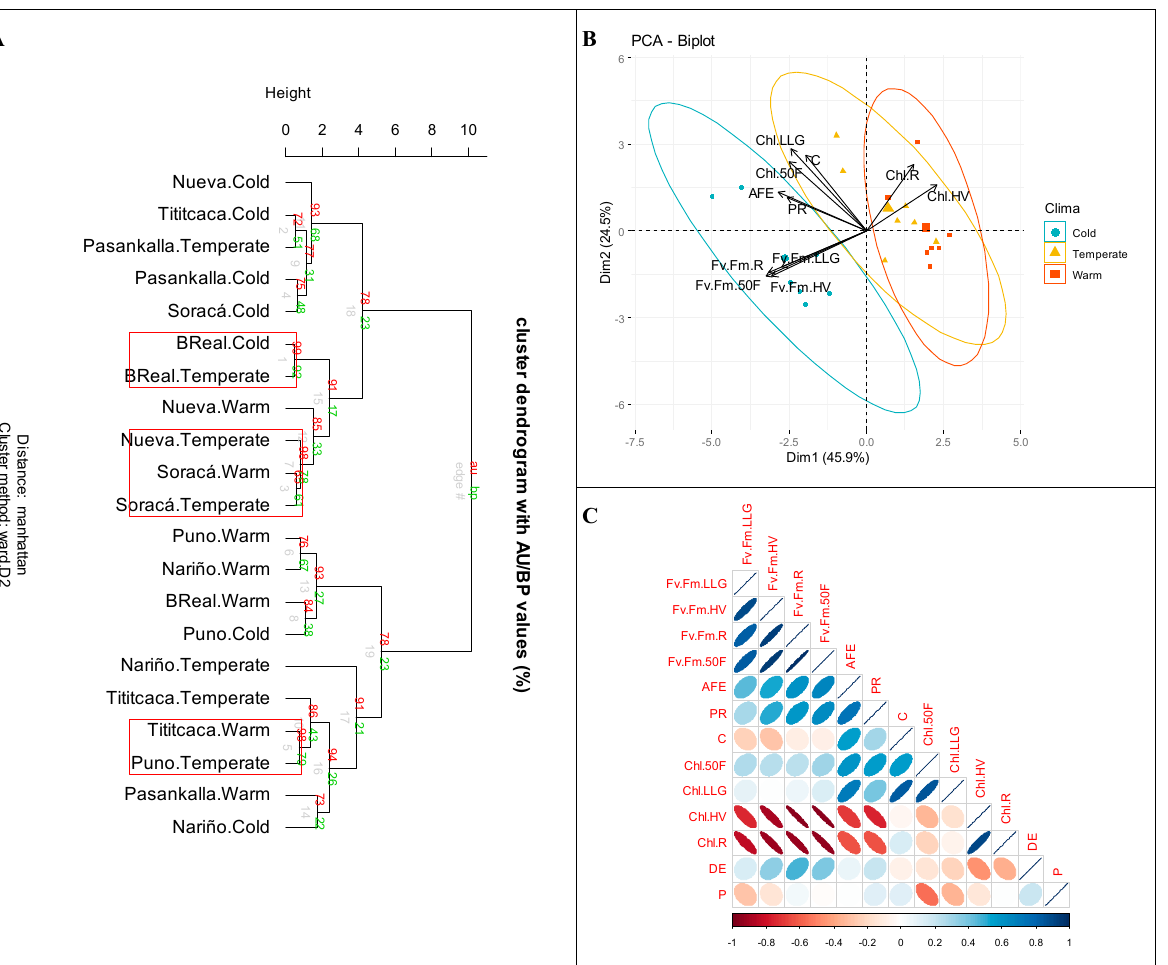
Figure 6. Grouping of treatments with respect to their physiological response. ( A ) Bootstrap-based cluster analysis. AU: Approximately Unbiased; BP: Bootstrap Probability ( B ) Principal component analysis of physiological variables with climate grouping. ( C ) Spearman correlation. HV: true leaves, R: Branching, 50F: 50% flowering, LLG: grain filling, PR: grain pro- duction, AFE: specific leaf area, P: protein, Chl: chlorophyll content, Fv.Fm: maximum quantum efficiency of FSII, C: time to harvest, DE: stomatal density.